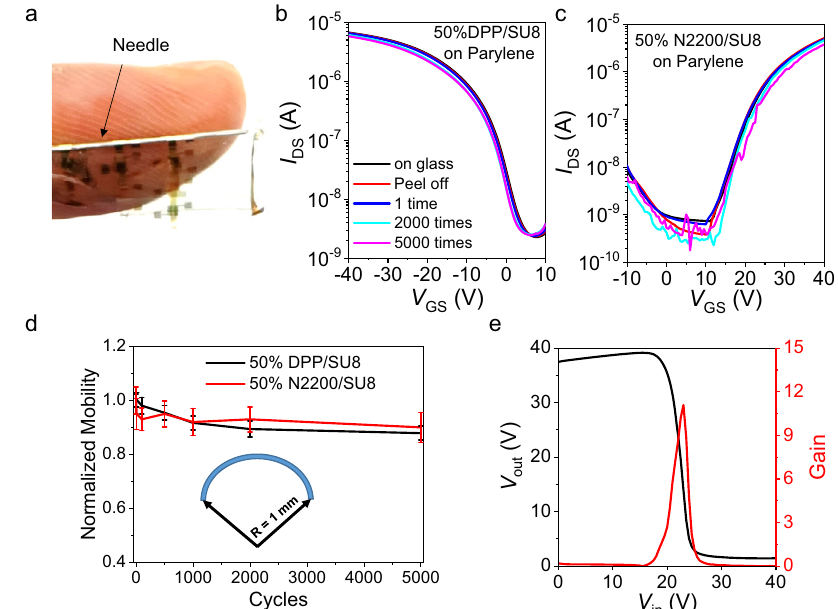
Fig. 6 Patterned ultra fl exible organic p- and n-type transistors. a Photo of an ultra fl exible DPP/SU8 device array on a 1.5 μ m thick parylene substrate. The semiconductor layers are patterned by photolithography while the S/D electrodes are patterned with metal mask. Transfer curves of ultra fl exible. b BGTC 50% DPP/SU8 devices and c BCTG 50% N2200/SU8 devices before and after bending at a radius of 1 mm for the indicated repetitions. The V DS is 40 V.